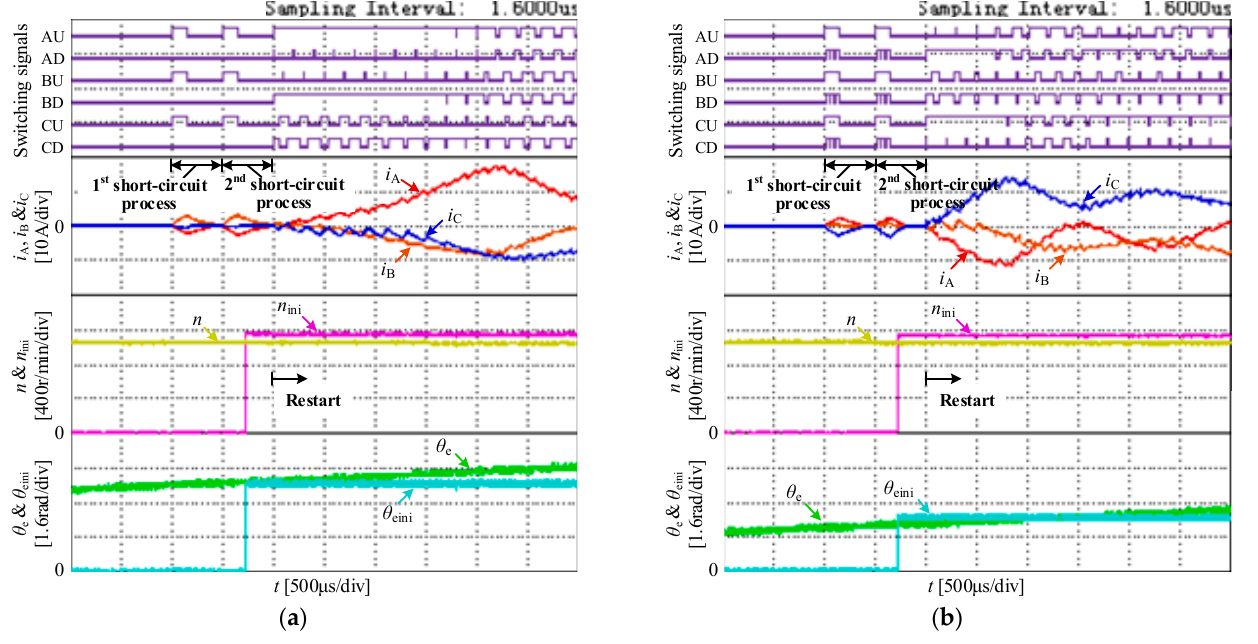
Figure 11. Experiments to compare the estimation of the initial motor speed and rotor position under different methods: ( a ) traditional ZVSM; ( b ) proposed SZVSM.